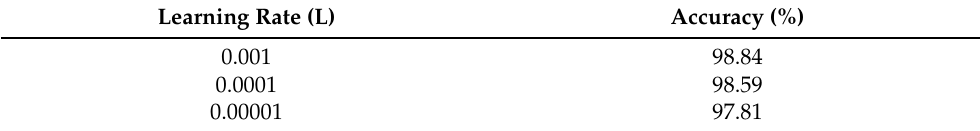
Table 7. Traffic sign recognition accuracy (%) at different learning rates (B = 64, O = Adam). Learning Rate (L)